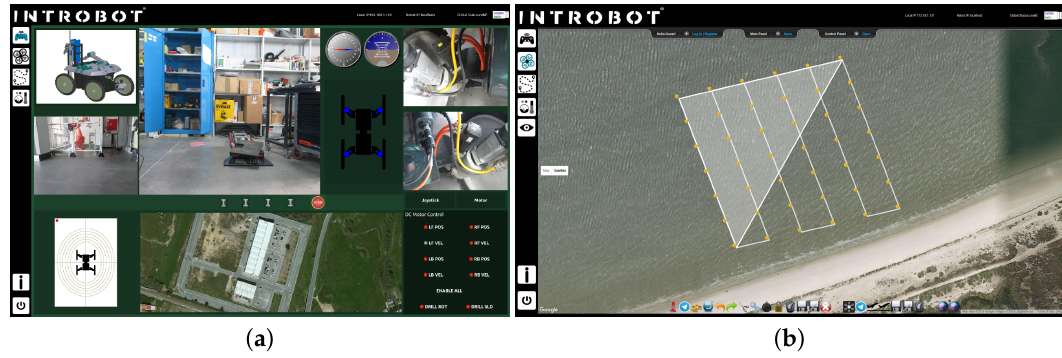
Figure 14. Mission control graphical user interfaces. ( a ) UGV’s tele-operation view; ( b ) UAV’s aerial survey configuration view. In orange are depicted the geo-referenced points that define the area of interest while in yellow the waypoints the UAV needs to follow during the